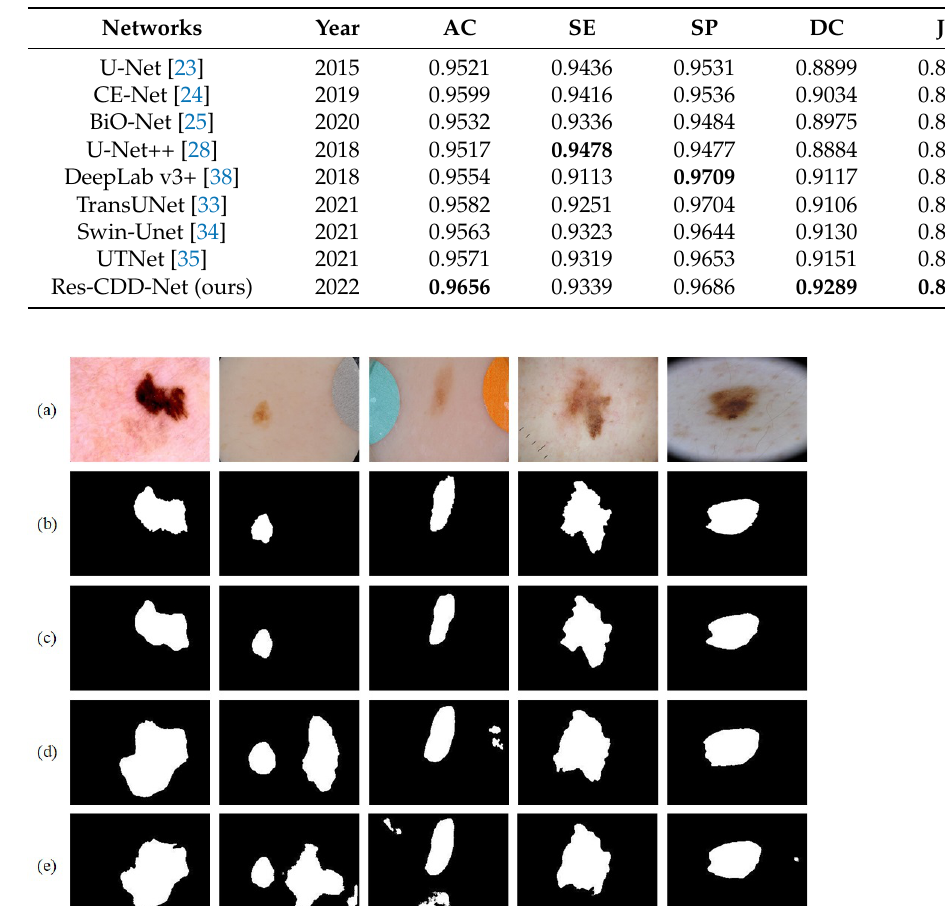
Figure 10. Segmentation results on the ISIC-2016 dataset: ( a ) original image; ( b ) ground truth; ( c ) seg- mentation result; ( d ) segmentation result from U-Net; and ( e ) segmentation result from BiO-Net.